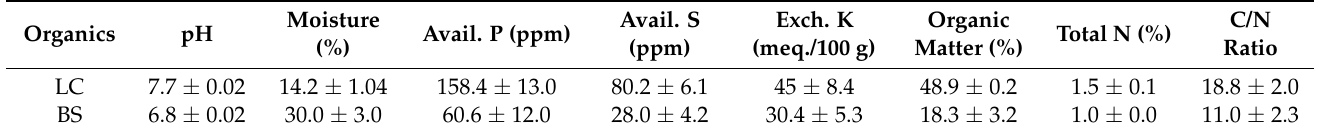
Table 2. Chemical properties of the prepared Trichocompost and bio-slurry; n = 3.